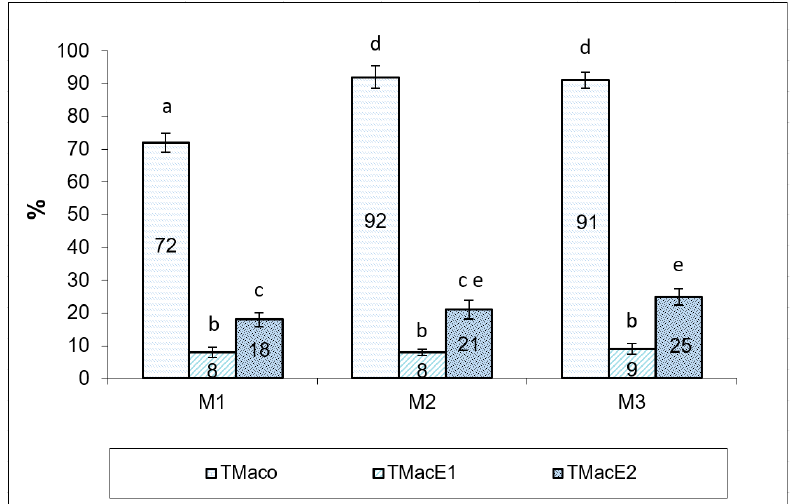
Figure 3. Spermatozoa total motility (%), registered in semen samples from the three Russian sturgeon males (M1, M2, M3), before and after cryopreservation with both extenders (E1 and E2). TMaco—total motility after collection; TMacE1—total motility after cryopreservation with extender 1; TMacE2—total motility after cryopreservation with extender 2. Different letters indicate significant differences ( p ≤ 0.01).